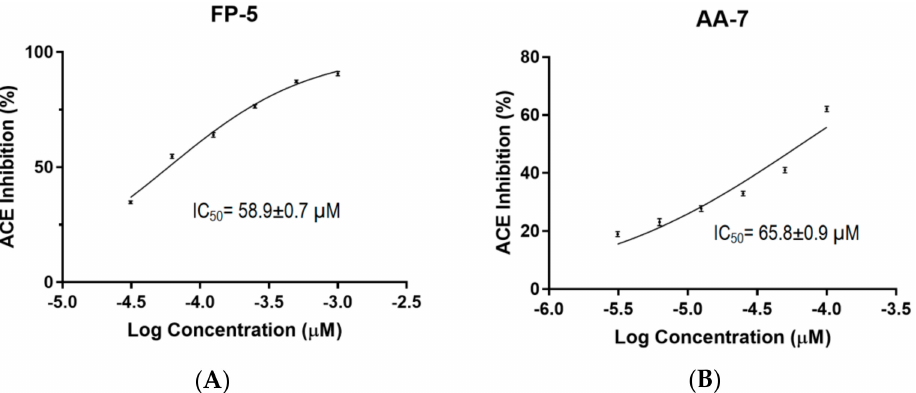
Figure 4. The IC 50 values of the two potent ACE inhibitory (ACEI) peptides. ( A ) The IC 50 determination for FP-5; ( B ) The IC 50 determination for AA-7. The IC 50 values were calculated from triplicate data using Graphpad Prism 6.0 by a nonlinear